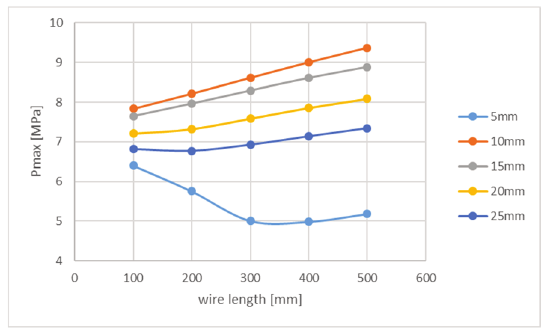
Fig. 5. Changes in the pressure in the indicator channel in relation to the distance from the combustion chamber